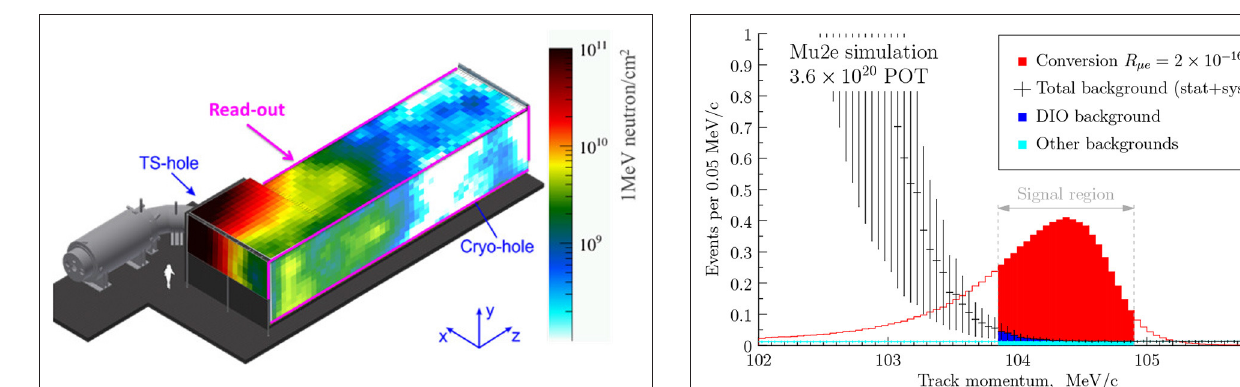
FIGURE 19 | Signal and backgrounds for nominal Mu2e exposure, for a signal of R µ e = 2 × 10 − 16 . The shape of the conversion signal, and the reason its mean is below the conversion energy, is largely due to dE / dx in the stopping target, as explained in section 4.3.